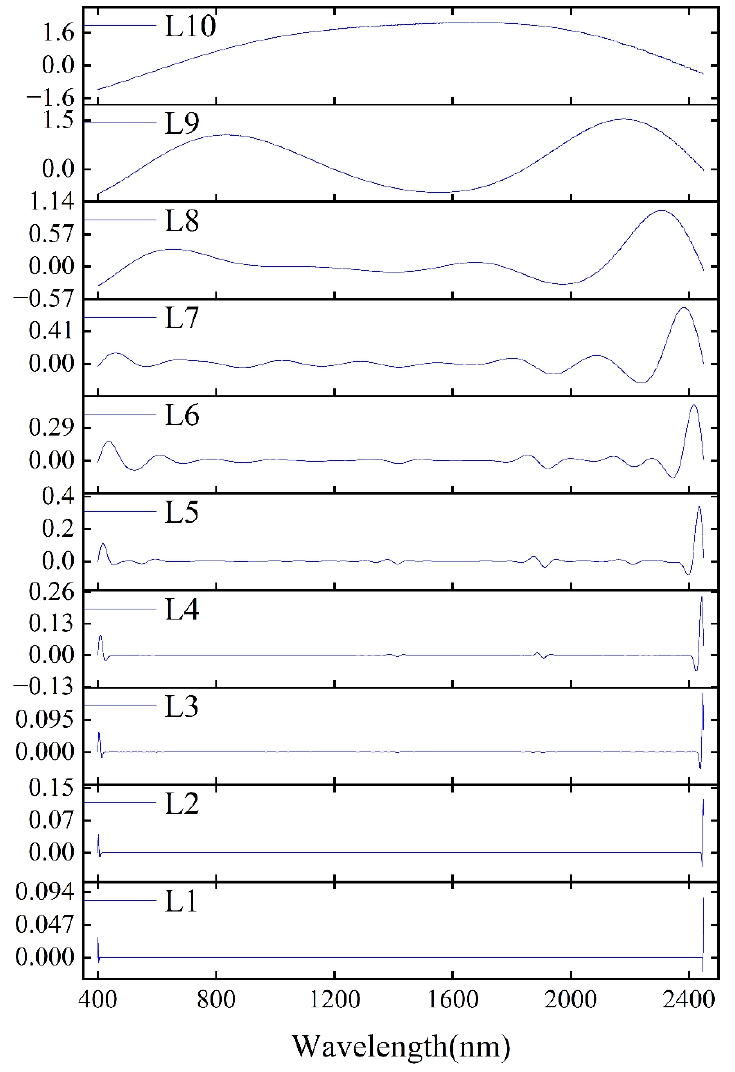
Figure 4. CWT spectra at different scales.